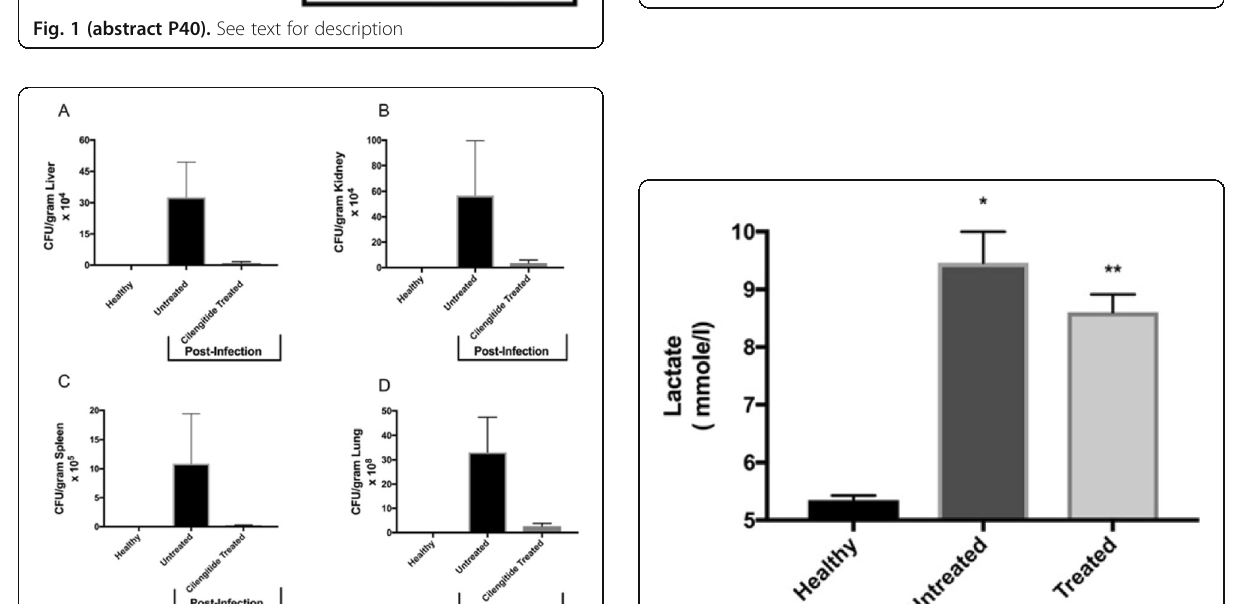
Fig. 3 (abstract P40). See text for description